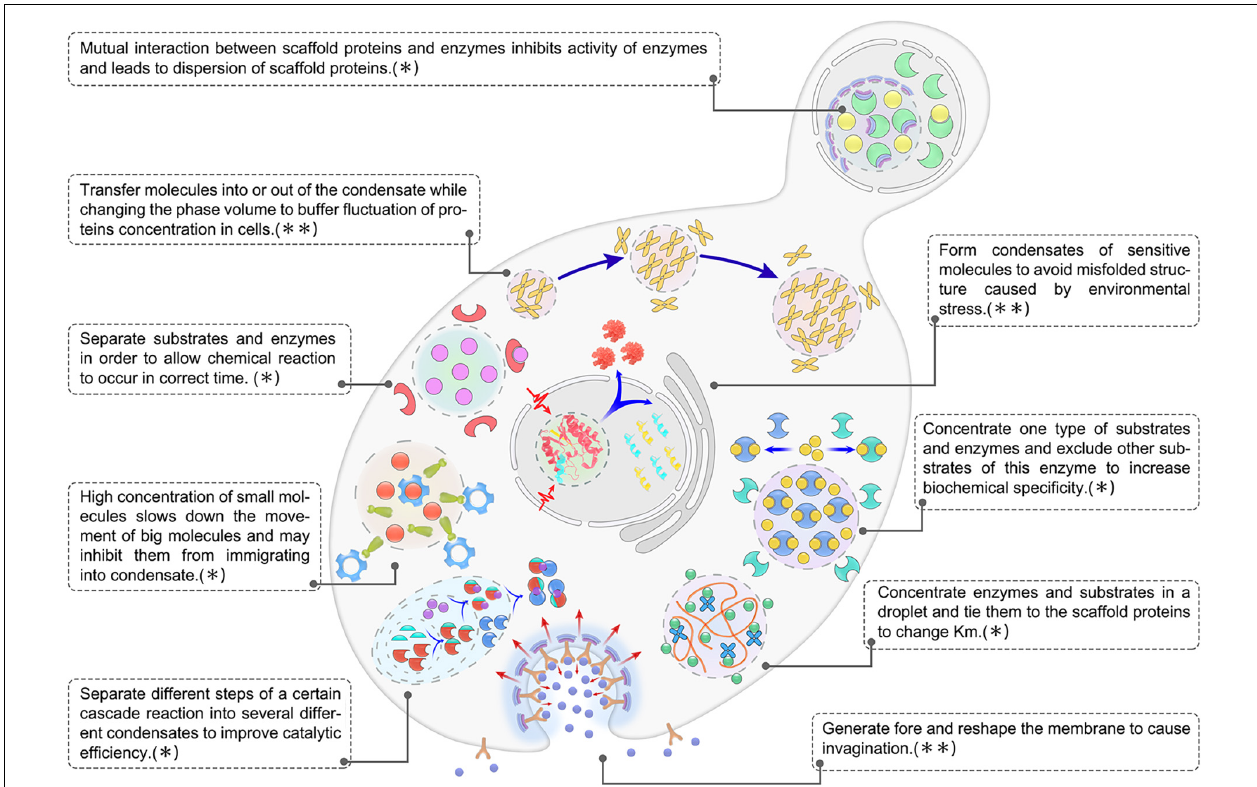
FIGURE 4 | Overview of biological functions of biomolecular condensates in microbial cells. The image shown is representative of nine main functions of LLPS in microbial condensates, which could be further summarized into two categories: ∗ ,condensates play a role in regulating metabolic flux. ∗∗ ,condensates play a role in acting against noise and